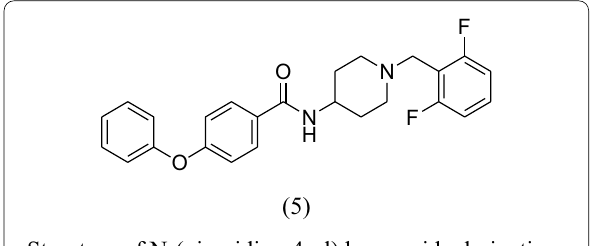
Fig. 15 Structure of trifluoromethyl piperidine derivative